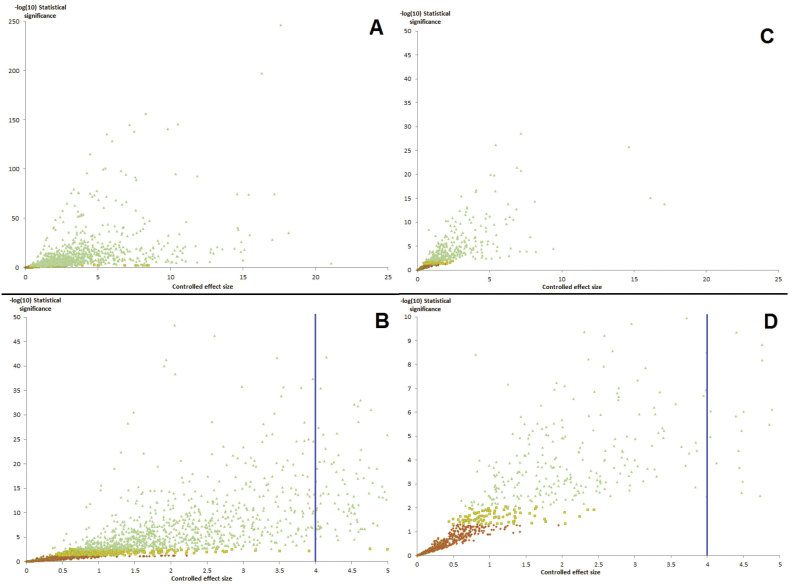
Logarithmic plot of the same data as in Figure 4, showing controlled unpooled effect size (x-axis) versus a logarithm of statistical significance (p<x) (y-axis). Note the number of instances of statistically significant variation ignored under the Isler et al. (1998) approach (green triangles, to the left of the purple line). Figures 5A, B use all 2348 pairwise comparisons for voice. Figure 5C, D show all 822 pairwise comparisons for biometrics. Figures 5B, D are close-ups of Figures 5A, C respectively, showing the area below 5 effect sizes. Red rhombuses, which are almost continuous along the x-axis on the left hand side of the two upper graphs, represent failure of tests of statistical significance. Yellow squares represent possible statistical significance, less than p<0.05 but failing tests of significance after applying Bonferroni correction. Green triangles represent statistically significant outcomes. Those outcomes to the right of the purple line are given credit as diagnosable under the Isler et al. (1998) test of species rank. Note also in the upper graphs the handful of yellow squares at effect sizes of greater than 4, which represent statistically insignificant outcomes which are nonetheless given credit under the Isler et al. (1998) model.